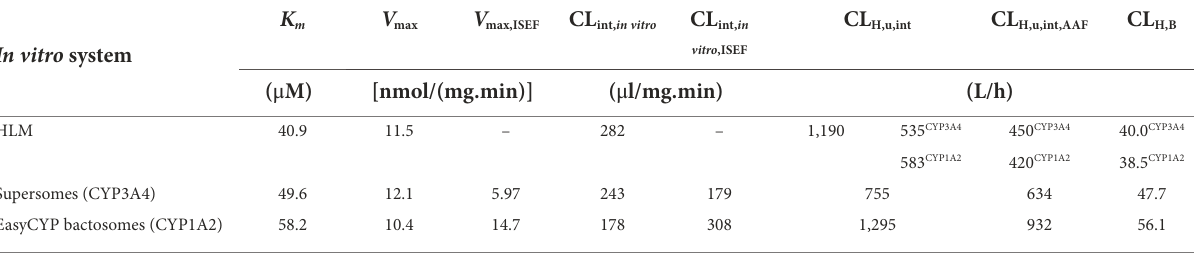
TABLE 3 Overview of the K m , V max , ISEF corrected V max , CL int, in vitro , ISEF corrected CL int, in vitro , CL H,u,int , AAF corrected CL H,u,int and CL H,B for all experiments concerning AFB1 both in HLM and in rhCYPs. K m In vitro system